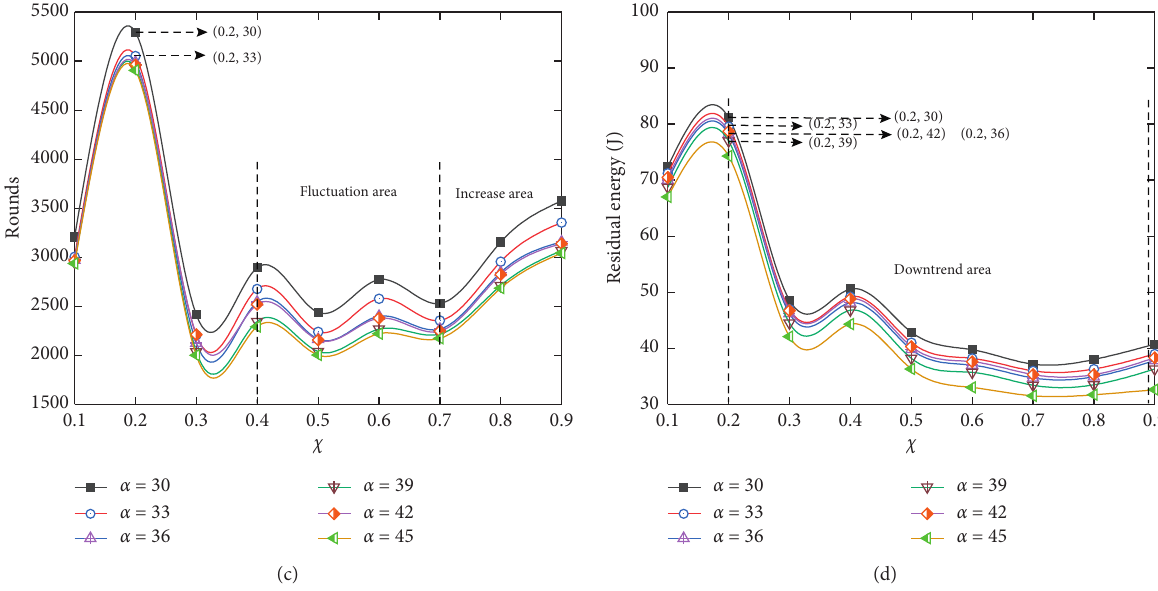
Figure 10: Combination impact of χ and α on assessment metrics, (a) death round of the first node with varying χ and α : (b) death round of half nodes with varying χ and α , (c) death round of 80% nodes with varying χ and α , and (d) residual energy with varying χ and α